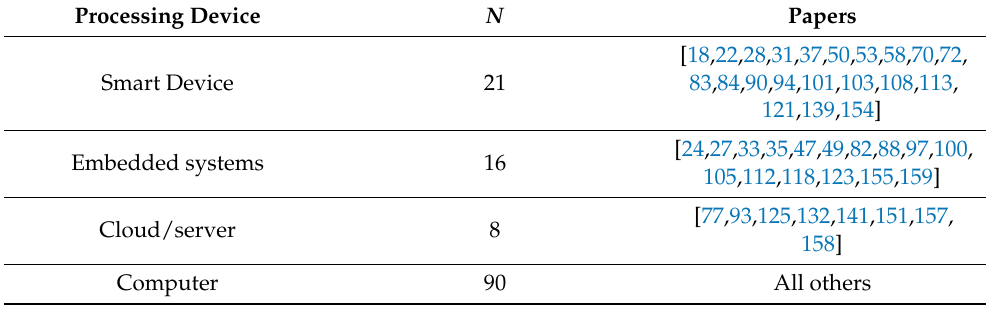
Table 6. BMF system or application processing device type.